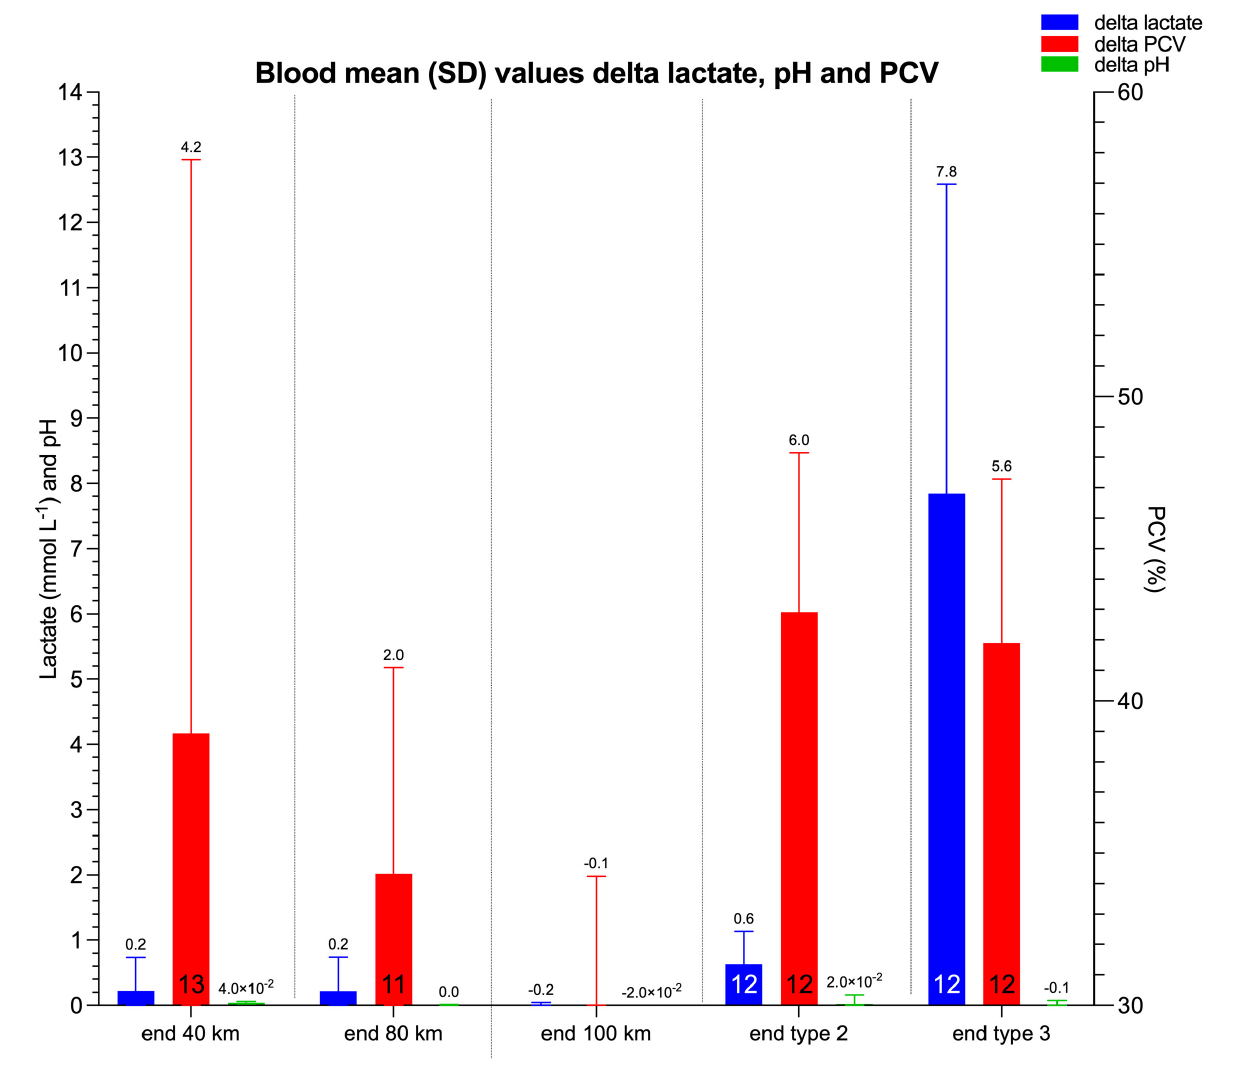
FIGURE 7 | Bar graph of blood parameters: lactate and pH on the y -axis presented as mmol L − 1 and the number, respectively, and the PCV (Hct) on the right y-axis presented as %. The type of exercise is presented on the x -axis as pre-, and post-ride in endurance and trotter exercises. The mean value is presented on top of the bar while sample size at the bottom in